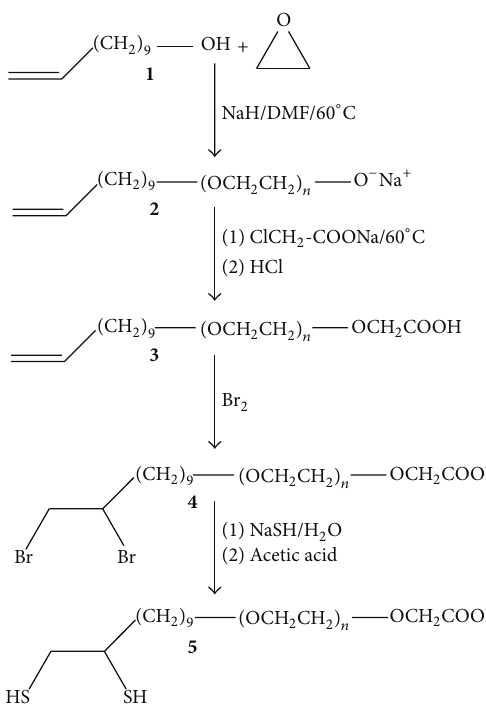
Scheme 8: Synthesis of bifunctional PEG linker using conjugation with